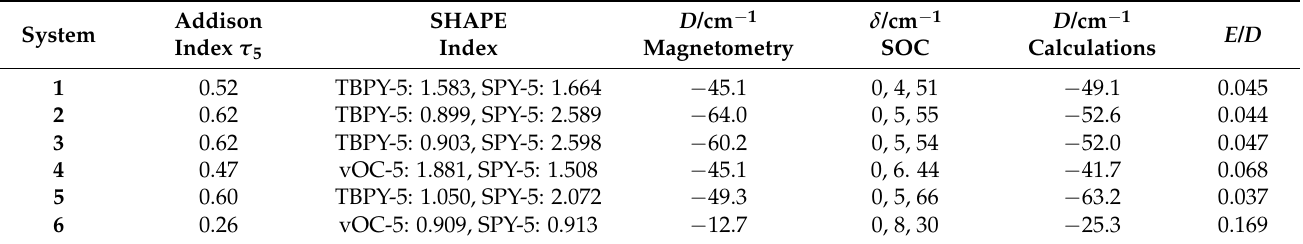
Table 6. Magnetometric and ab initio data for a set of pentadentate Ni(II) complexes comprising Schiff base ligands 1